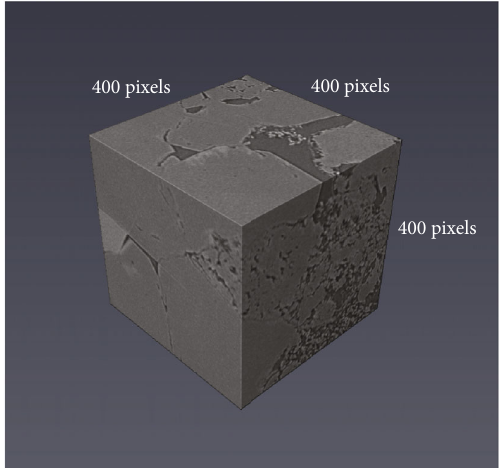
Figure 3: Digital rock obtained from CT with 0.7 μ m/pixel and 400 × 400 × 400